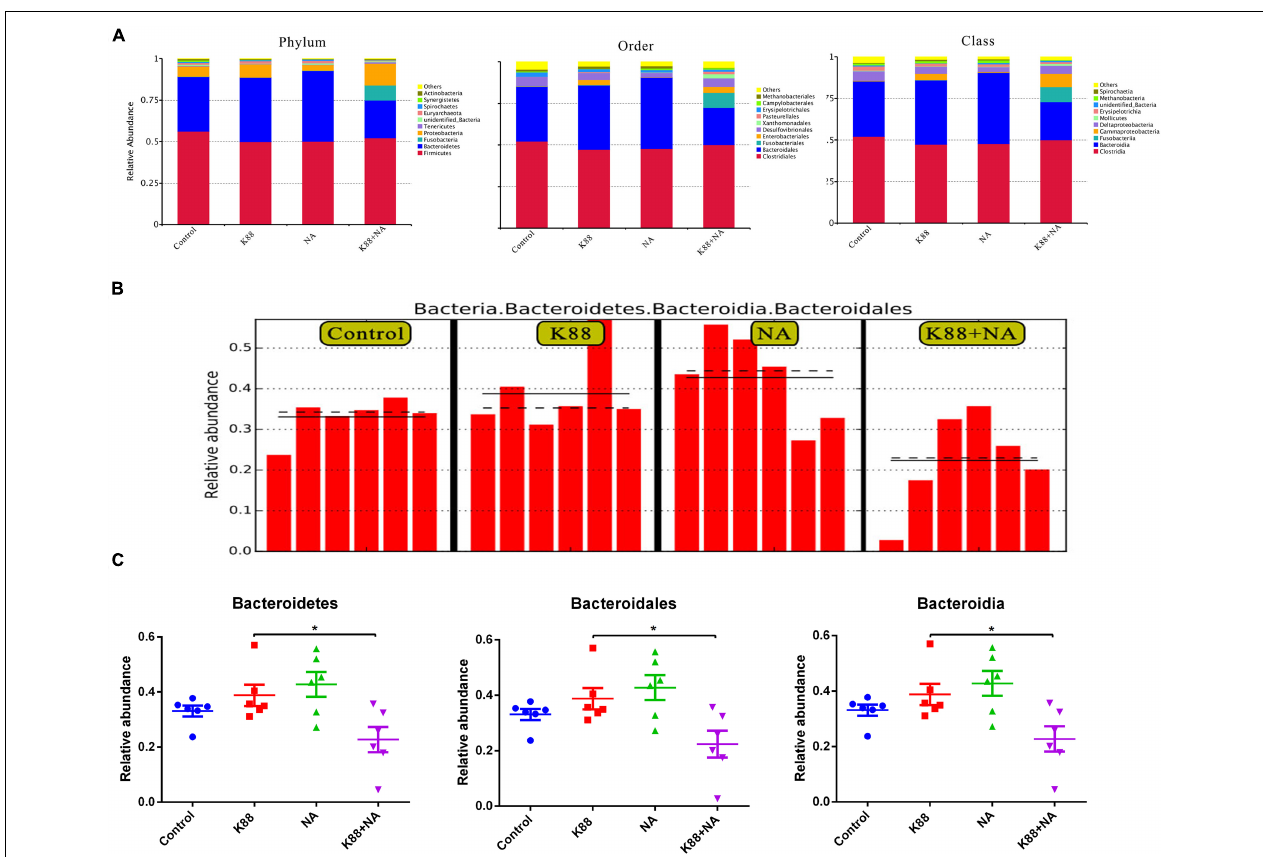
FIGURE 5 | Nicotinic acid improved the classification of the bacterial community composition caused by E. coli infection in colonic contents of weaned piglets. The relative abundance of top 10 in phylum, order and class (A) , the LEfSe analysis identified the biomarker bacterial species (B) , the significantly different species at each level (C) . * P <